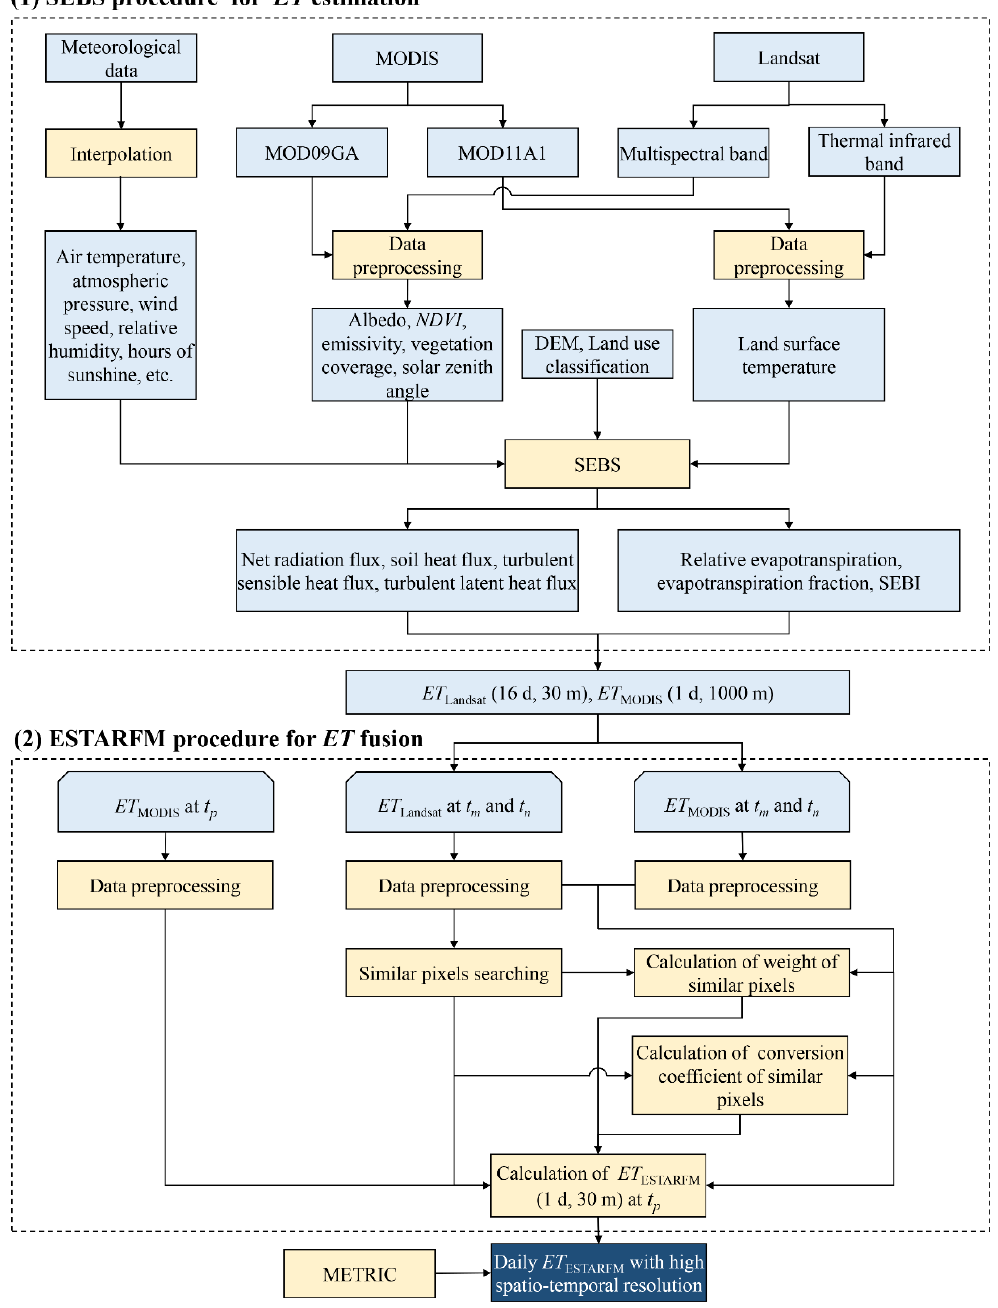
Figure 2. Flow chart of the fusion process for ET ESTARFM with high spatiotemporal resolution. The Digital Elevation Model (DEM) data required for atmospheric